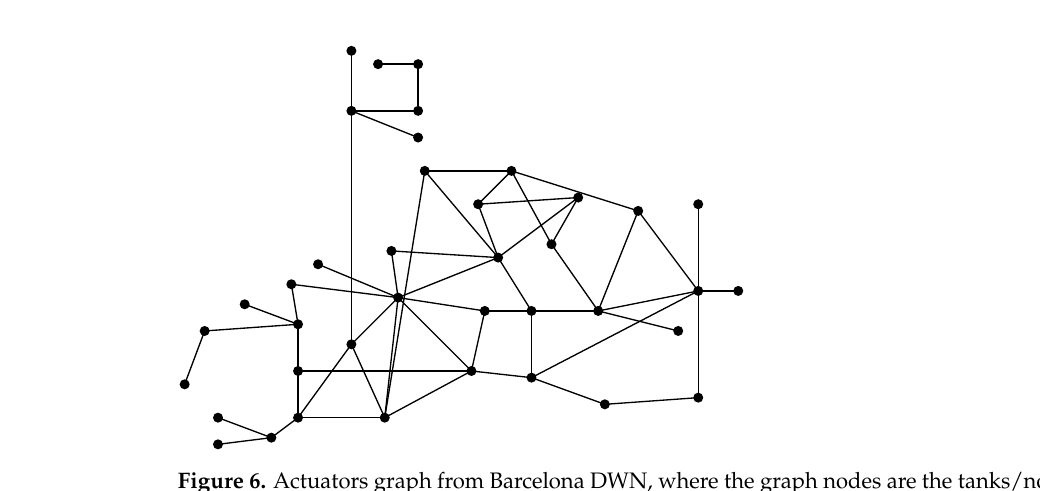
Figure 6. Actuators graph from Barcelona DWN, where the graph nodes are the tanks/nodes and the edgde nodes are the pumps/valves.